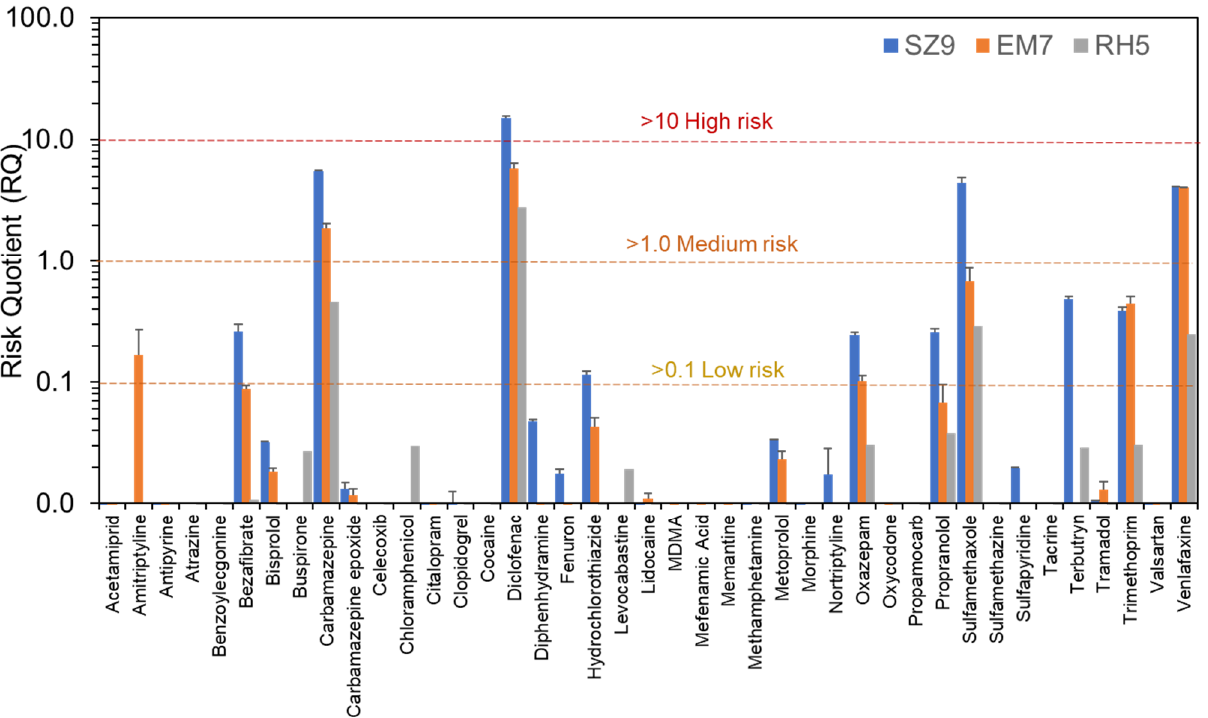
Figure 6. Risk quotients (MEC/PNEC) for sites with high measured CEC concentrations in the R. Schwarzach (at SZ9), Emsbach (EM7), and Rhine (RH5). Error bars represent standard deviation in RQ arising from MEC for n = 3. For PNEC data, please refer to Table S9.